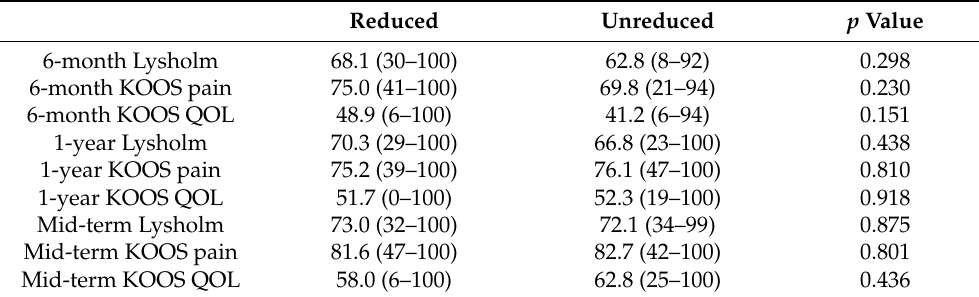
Table 4. Patient-reported outcome scores in reduced and unreduced fracture patient cohorts.